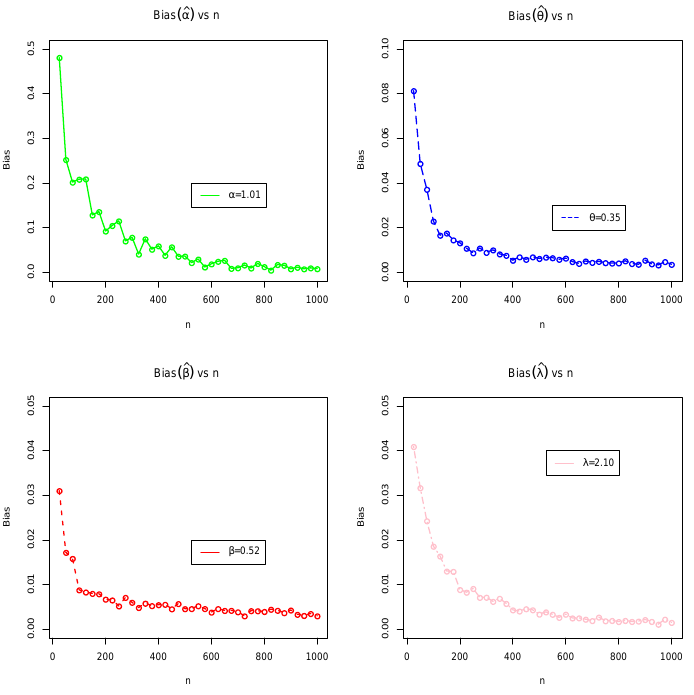
Figure 5. For set 1, bias plots of GAEPPRD: α = 1.01, θ = 0.35, β = 0.52, λ =